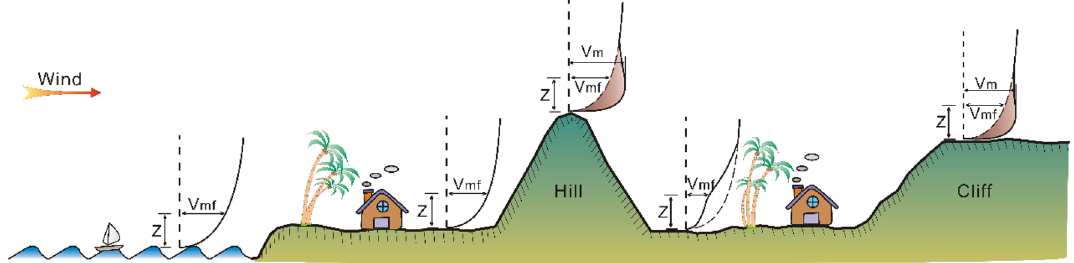
Fig. 3 Illustrative diagram of wind speed variations caused by topographic effects. Note Z (10 m) is the simulation height; V mf is the mean wind velocity above flat terrain; and V m is the mean wind velocity at height